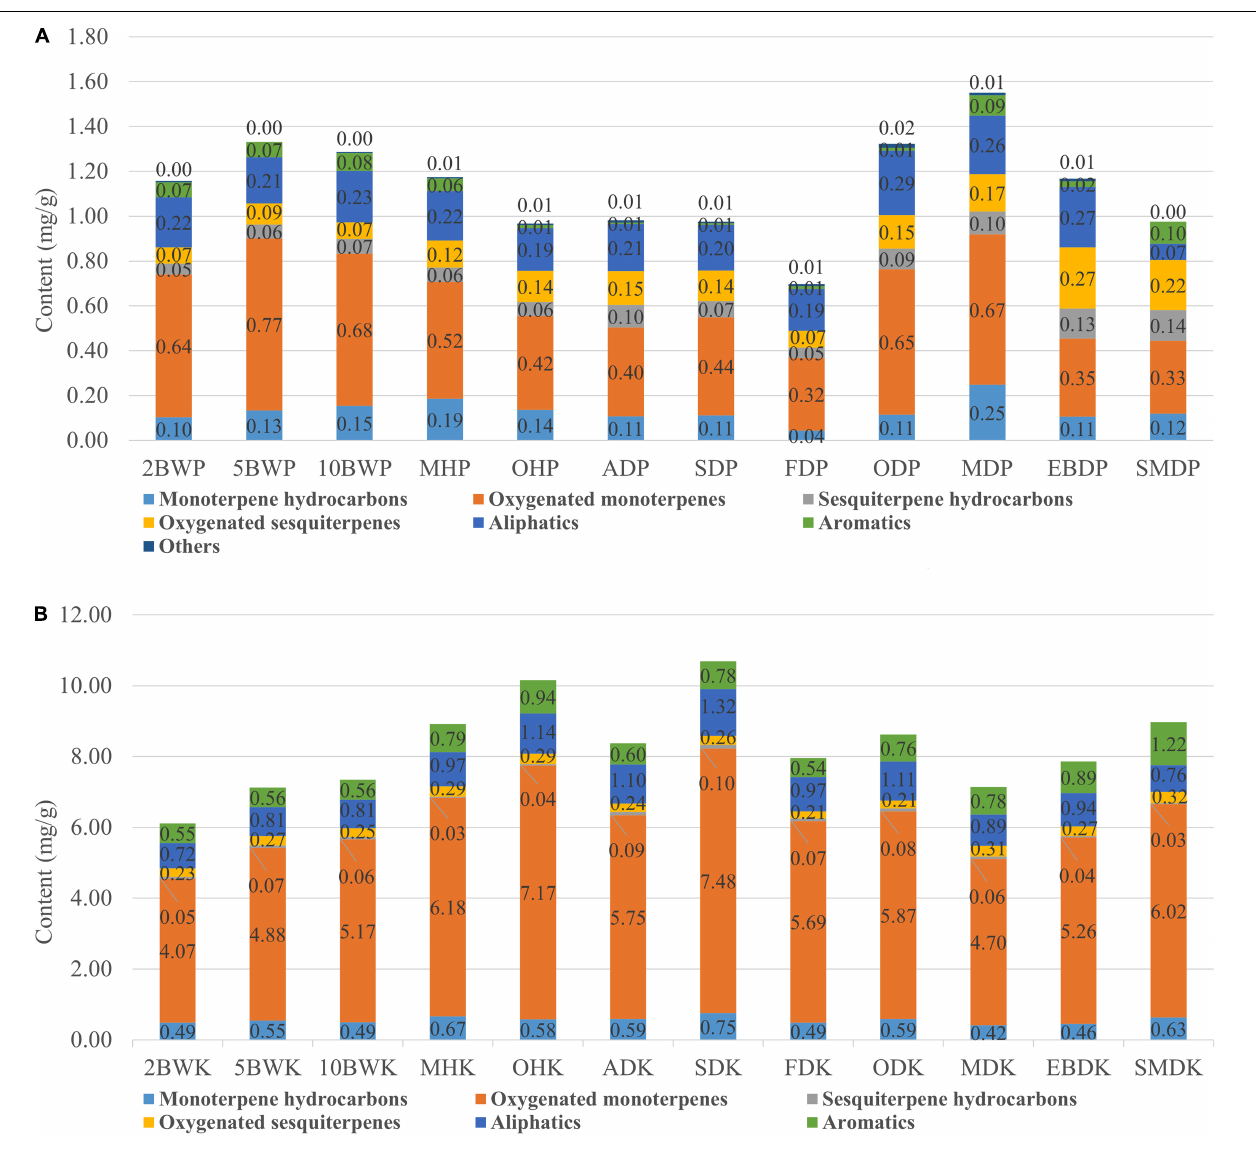
FIGURE 3 | Changes in the proportion of the different chemical families of volatiles in the pericarp (A) and kernel (B) of A. tsao-ko with different pre-drying and drying